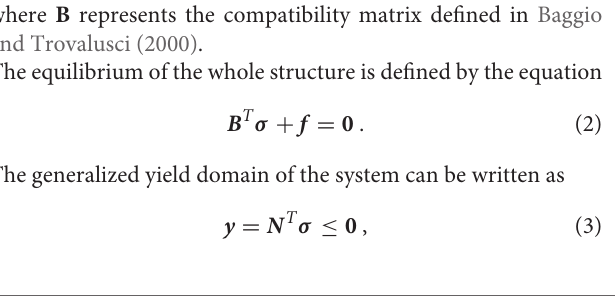
where N is the block-diagonal gradient matrix referred to the adopted failure